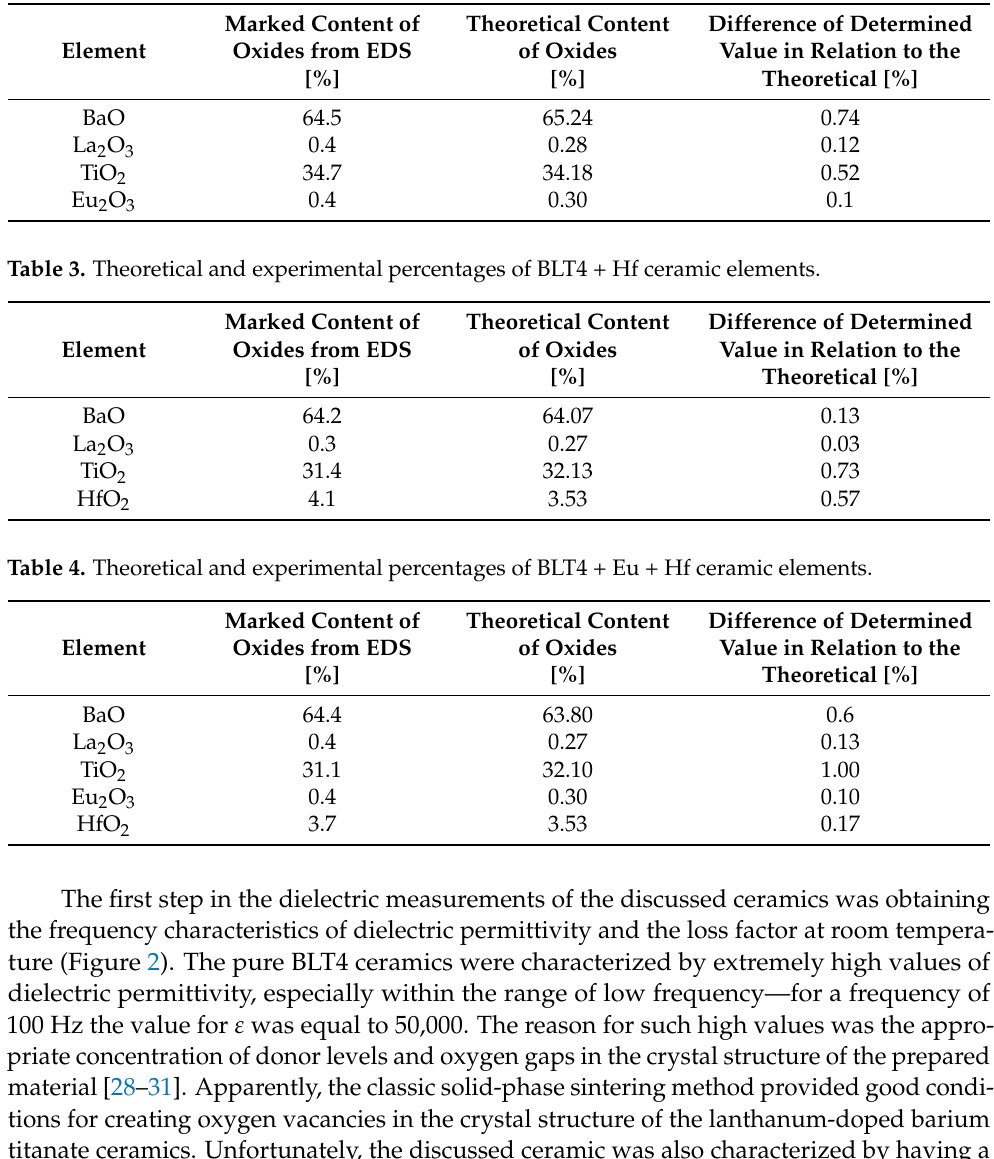
Table 2. Theoretical and experimental percentages of BLT4 + Eu ceramic elements.